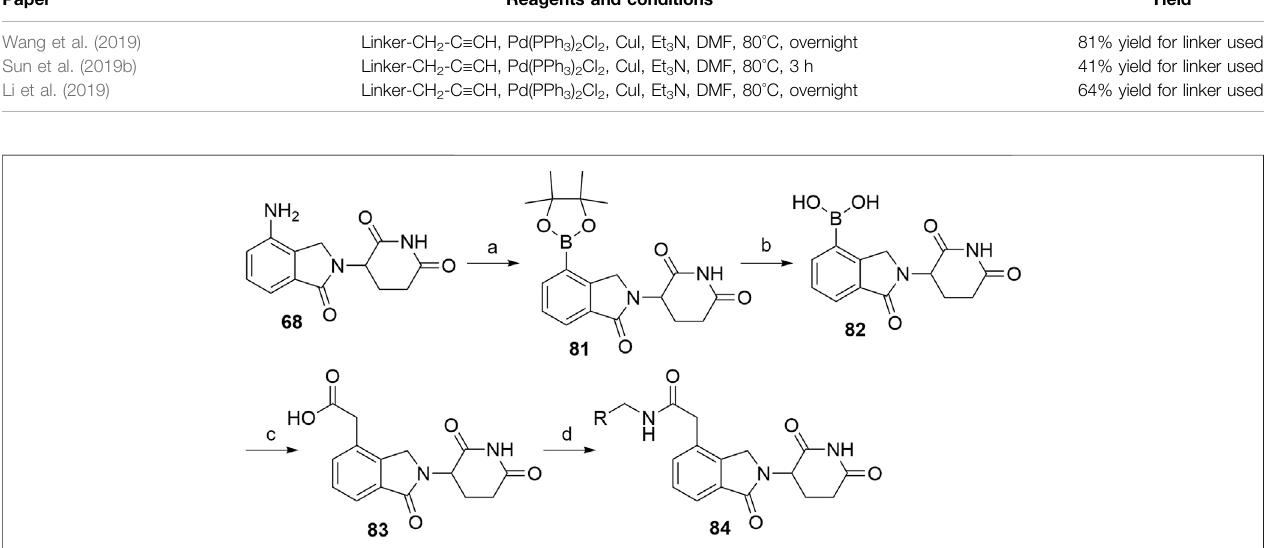
TABLE 5 | Reagents, conditions, and yields for the conversion of 78 to 79 ( Scheme 16 , step c). Paper Reagents and